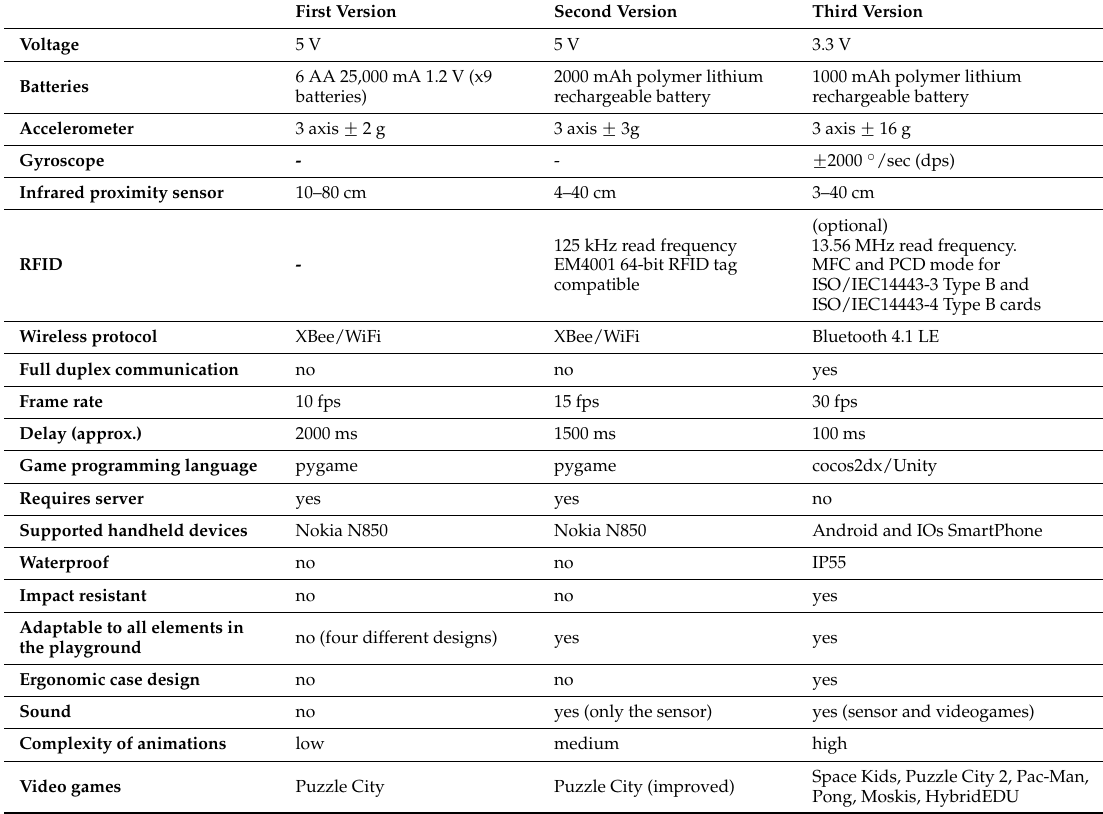
Table 1. Technical specifications and other characteristics for the different versions of the